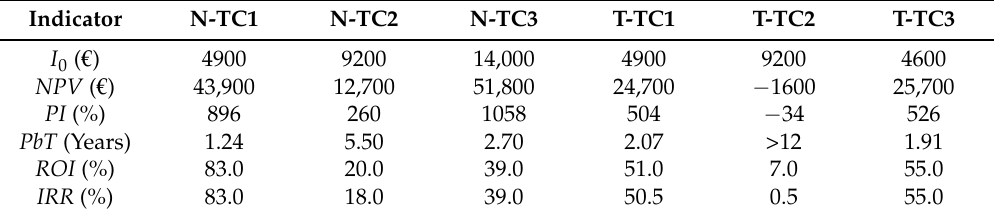
Table 3. Economic indicators for investments regarding cases with no tank (N-) and with tank (T-).